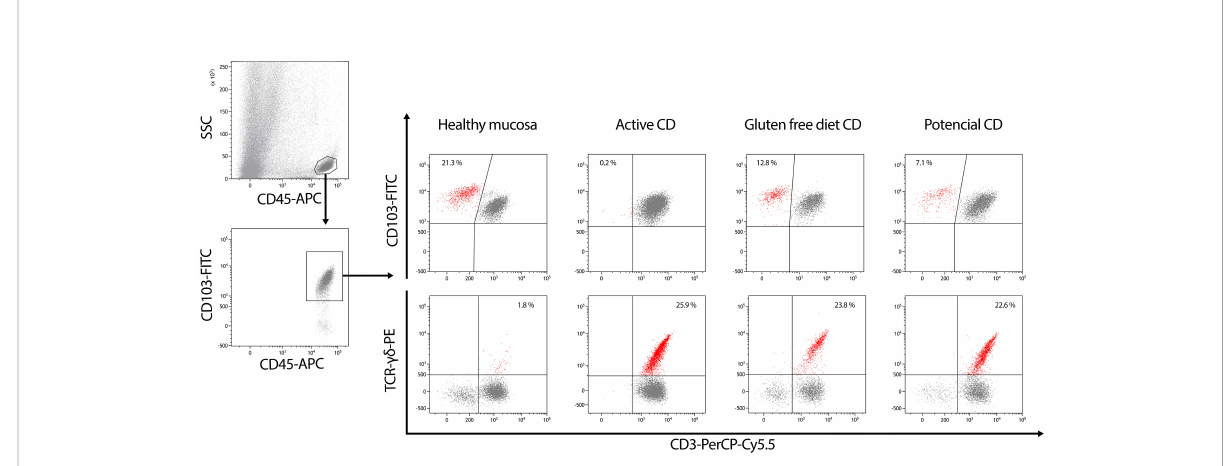
FIGURE 1 Gating strategy in the routine fl ow cytometric analysis of CD45 + SSC low cells isolated from the epithelium of duodenal biopsies. Surface CD3 (sCD3), TCR gd and CD103 staining are selected in order to estimate the percentages of sCD3 - CD103 + IELs (upper-left quadrants on top line dot plots) and TCR gd + CD3 + IELs (upper-right quadrants on bottom dot plots). Intraepithelial lymphogram pro fi les represent an immunological signature of the different forms of celiac disease